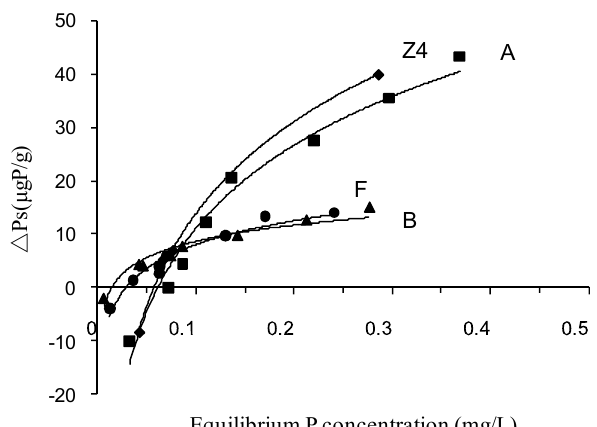
Fig. 3. Relationship between equilibrium solution P concentration (mgL − 1 ) and the amounts of adsorbed or desorbed P (µg Pg − 1 ) Figure 3 Relationship between equilibrium solution P concentration (mg/L) and the amounts of with very low initial P concentrations in the incubation solutions (up to 0.5mgL − 1 ) for sediment samples A, B, F and Z4. adsorbed or desorbed P ( μ g P /g) with very low initial P concentrations in the incubation solutions (up to 0.5 mg/L) for sediment samples A, B, F and Z4. (fine particle fraction 27 % and 28 %, OM 0.66 % and 0.82 %,